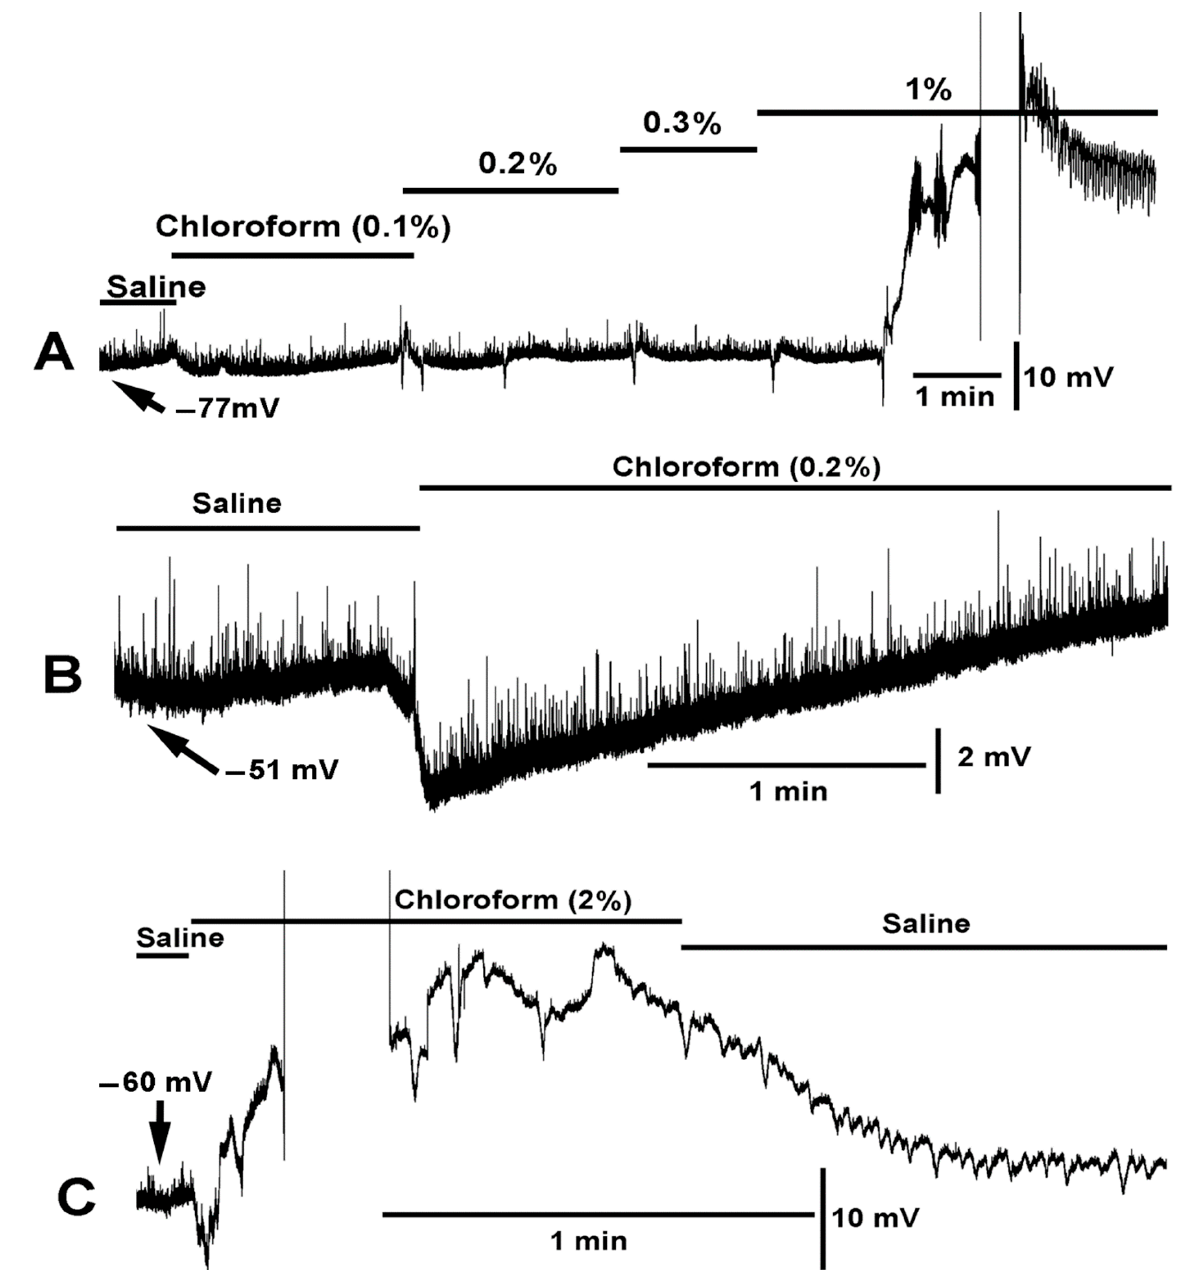
Figure 2. Dose dependent effect of chloroform on membrane potential and muscle contraction. ( A ) Chloroform in saline produced little effect at 0.1% concentration on hyperpolarizing the membrane potential. As the percent of chloroform increased a more pronounced rapid hyperpolarization (<1 s) would occur. Random hyperpolarization occurred during the 0.2% exposure. As the percent of chloroform reached 1% the muscle produced strong contractions, dislodging the intracellular electrode, and would continue to produce waves of contractions as shown at the end of the trace. ( B ) A saline with 0.2% chloroform produced a rapid hyperpolarization followed with a repolarization within 1 min. Note: The miniature excitatory junction potentials (mEJPs) are still present during the hyperpolarization. ( C ) At 2% chloroform, a rapid hyperpolarization occurred followed by strong muscle contraction making it difficult to maintain an intracellular recording. After reestablishing an intracellular recording in the same muscle, the repeated depolarization and hyperpolarization occurred due to muscle producing waves of contractions.